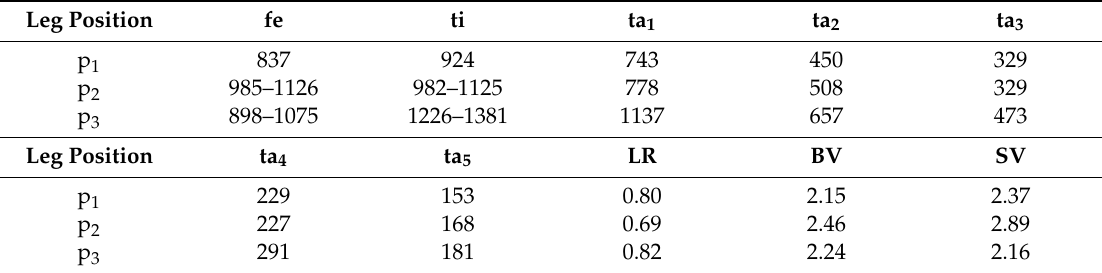
Table 4. Lengths (in µ m) and proportions of leg segments in Ablabesmyia americana Fittkau, female (n =